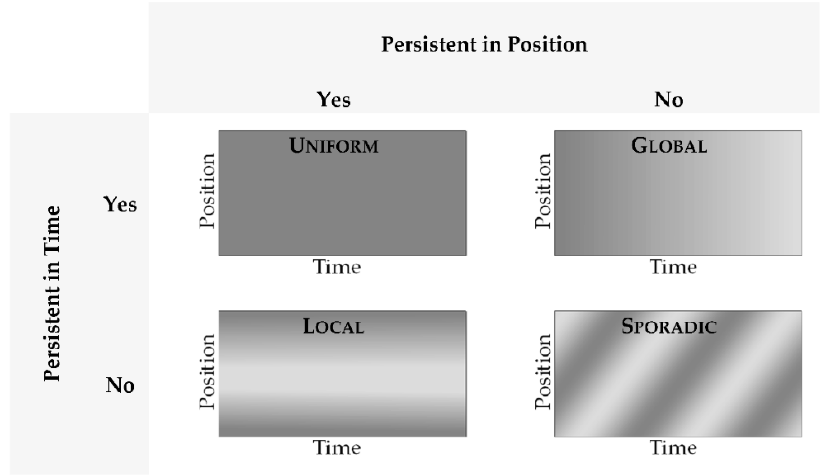
Figure 1. Schematic representation of classification of triboscopic features with an example given for each case. U NIFORM : No noteworthy features. G LOBAL : Features are persistent over the entire track. L OCAL : Features are at specific positions inside the track and persist over many cycles. S PORADIC : Features do not persist in either cycle or